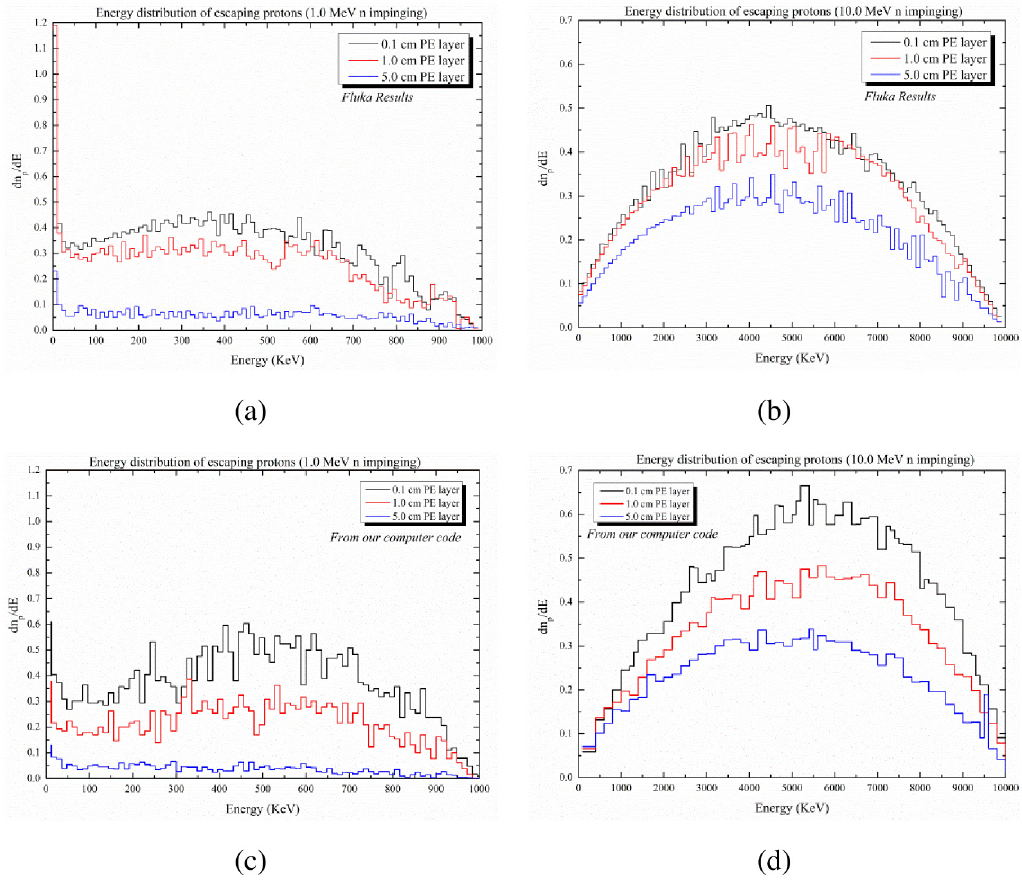
Fig 10. Comparison between the energy distributions of protons exiting from the opposite side of a PE layer obtained using the FLUKA code and our present code. (a) FLUKA results for 1 MeV neutrons impinging PE layer; (b) FLUKA results for 10 MeV neutrons; (c) Results from our computer code for 1 MeV neutrons; (d) Results from our computer code for 10 MeV